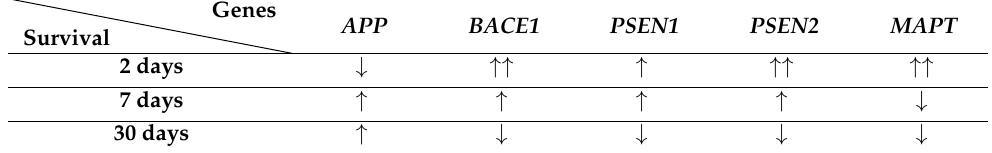
Table 1. Changes in the expression of amyloid protein precursor ( APP ), β -secretase ( BACE1 ), presenilin 1 ( PSEN1 ), presenilin 2 ( PSEN2 ), and tau protein ( MAPT ) genes in the rat CA1 area after brain ischemia. Genes APP BACE1 PSEN1 PSEN2 MAPT Survival 2 days ↓ ↑↑ ↑ ↑↑ ↑↑ 7 days ↑ ↑ ↑ ↑ ↓ 30 days ↑ ↓ ↓ ↓